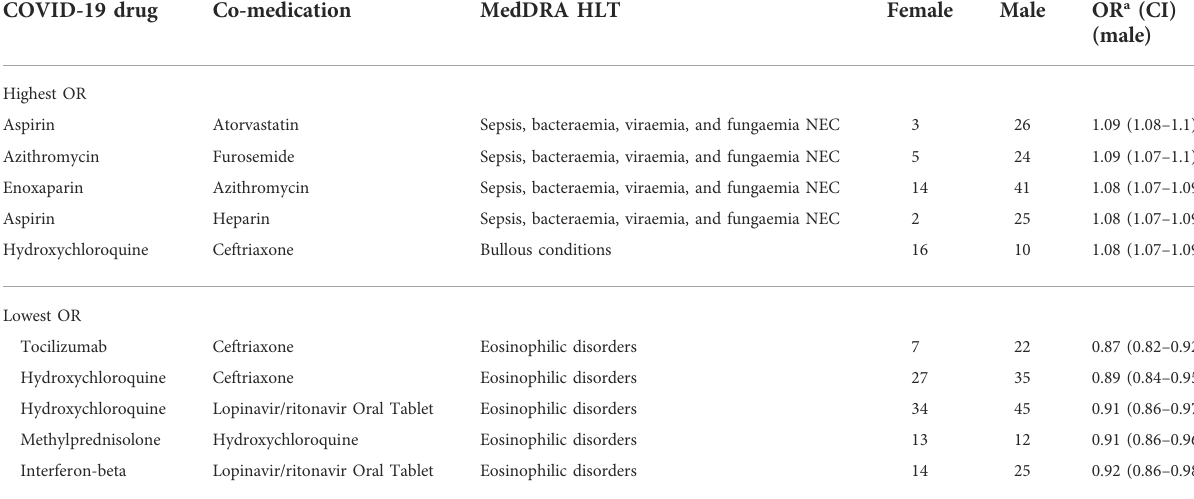
TABLE 3 The fi ve highest and lowest adjusted odds ratios (OR) of the DDI risk associated with gender. COVID-19